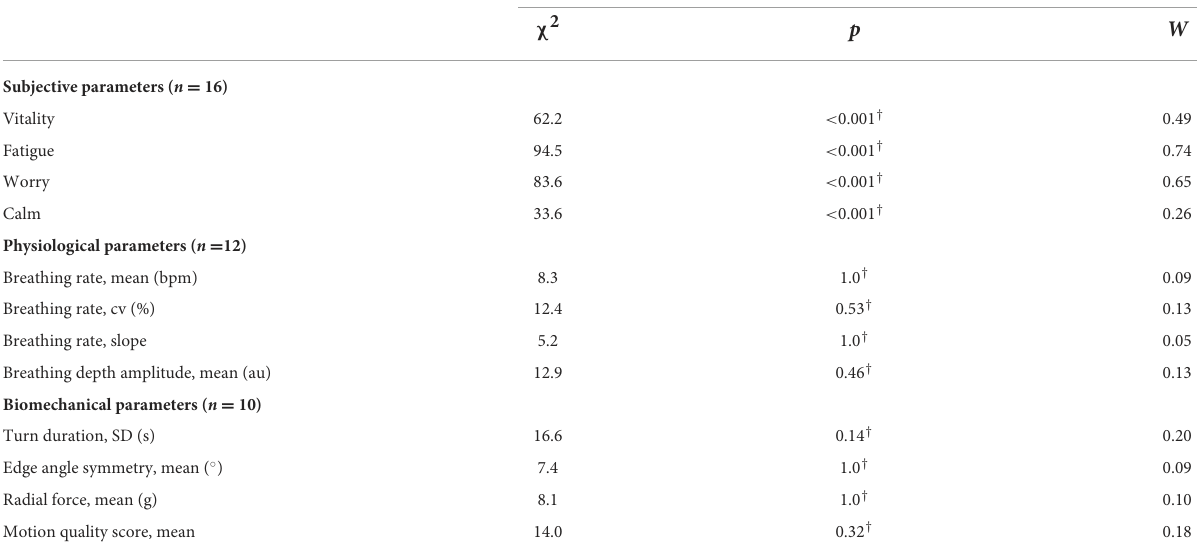
TABLE 3 Friedman’s ANOVA for subjective, physiological, and biomechanical